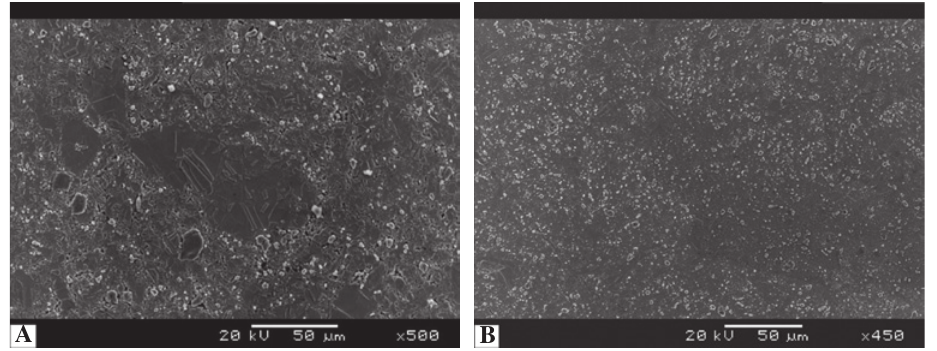
A B Figure 4 Microstructure of compacts made by PM process from powders mechanically alloyed for: (A) 5 h, (B) 25 h.